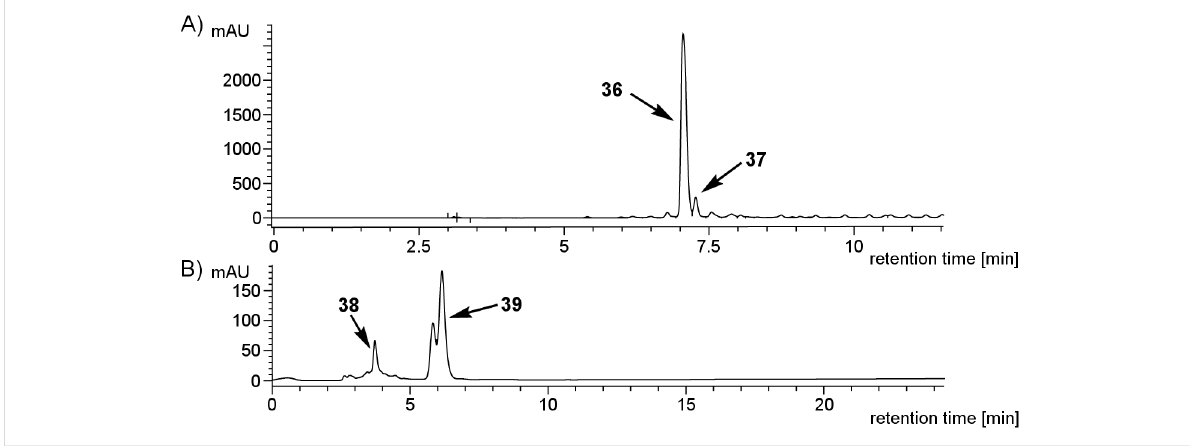
Figure 2: Representative HPLC chromatograms of glycosylation experiments on PS-based and water-compatible resins. (A) Tentagel (Nucleosil C4, 5% → 95% in 20 min, eluents: H 2 O and MeCN, detection at 254 nm). (B) Merrifield resin (Nucleosil C4, 50% → 80% in 30 min, eluents: H 2 O and MeCN, detection at 254 nm; the double peak for 39 is caused by an anomeric mixture).